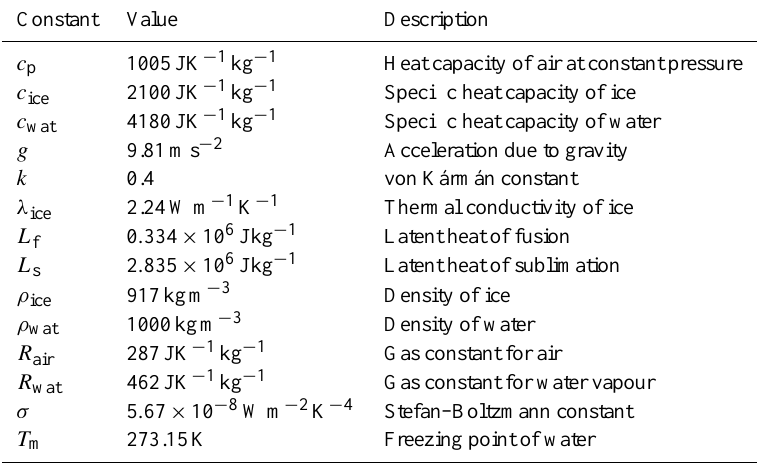
Table 1. Physical and model constants.